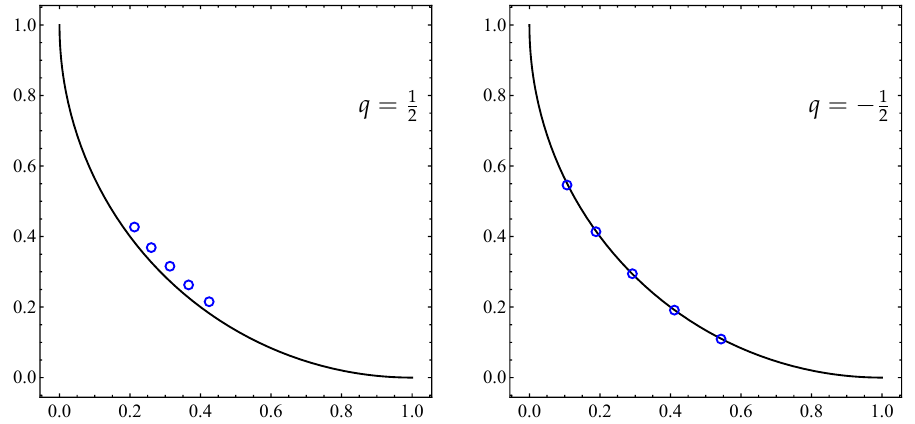
Figure 10. Optimal ∆ 1, q five-point set archives A for the connected Pareto front P 1 given by Equation (12) with p = 1 and q = ± 1/2.